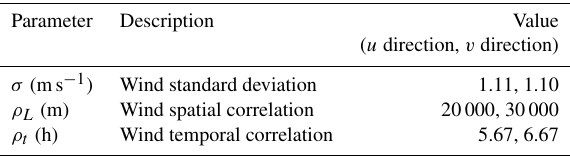
Table 1. Summary of the noise model parameters. Table 2. Summary of the data assimilation performance (MAE and